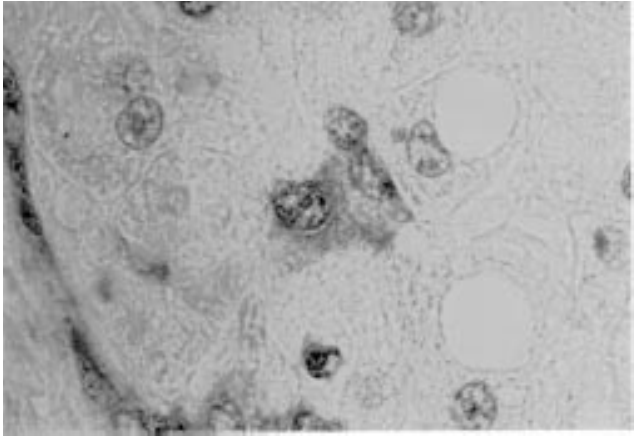
Fig. 2. Hepatocyte expressing CK 19 (red) and PCNA (black) (original magnification